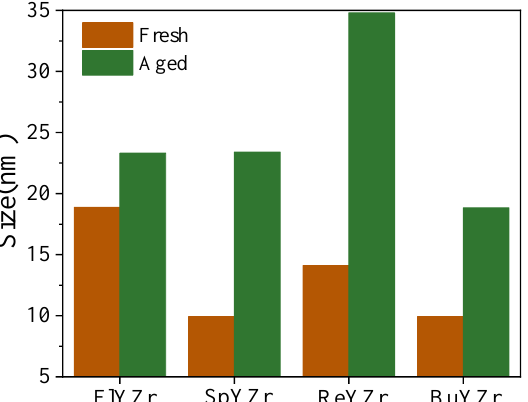
Figure 5. Statistical chart of average particle size of Y-ZrO 2 composite oxides with different mor- phologies.